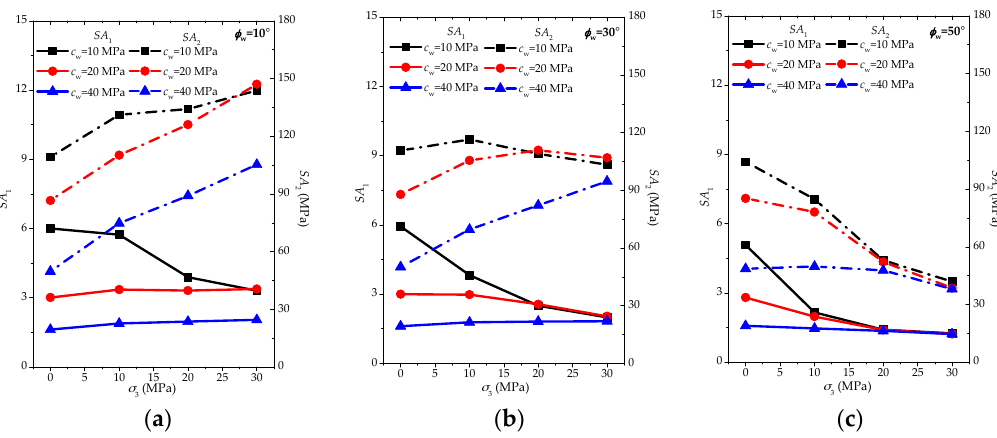
Figure 7. Influence of cohesion of weak planes with the certain friction angle ( a ) φ w = 10 ° ; ( b ) φ w = 30 ° ; and ( c ) φ w = 50 ° based on SA 1 (solid line) and SA 2 (dashed line).